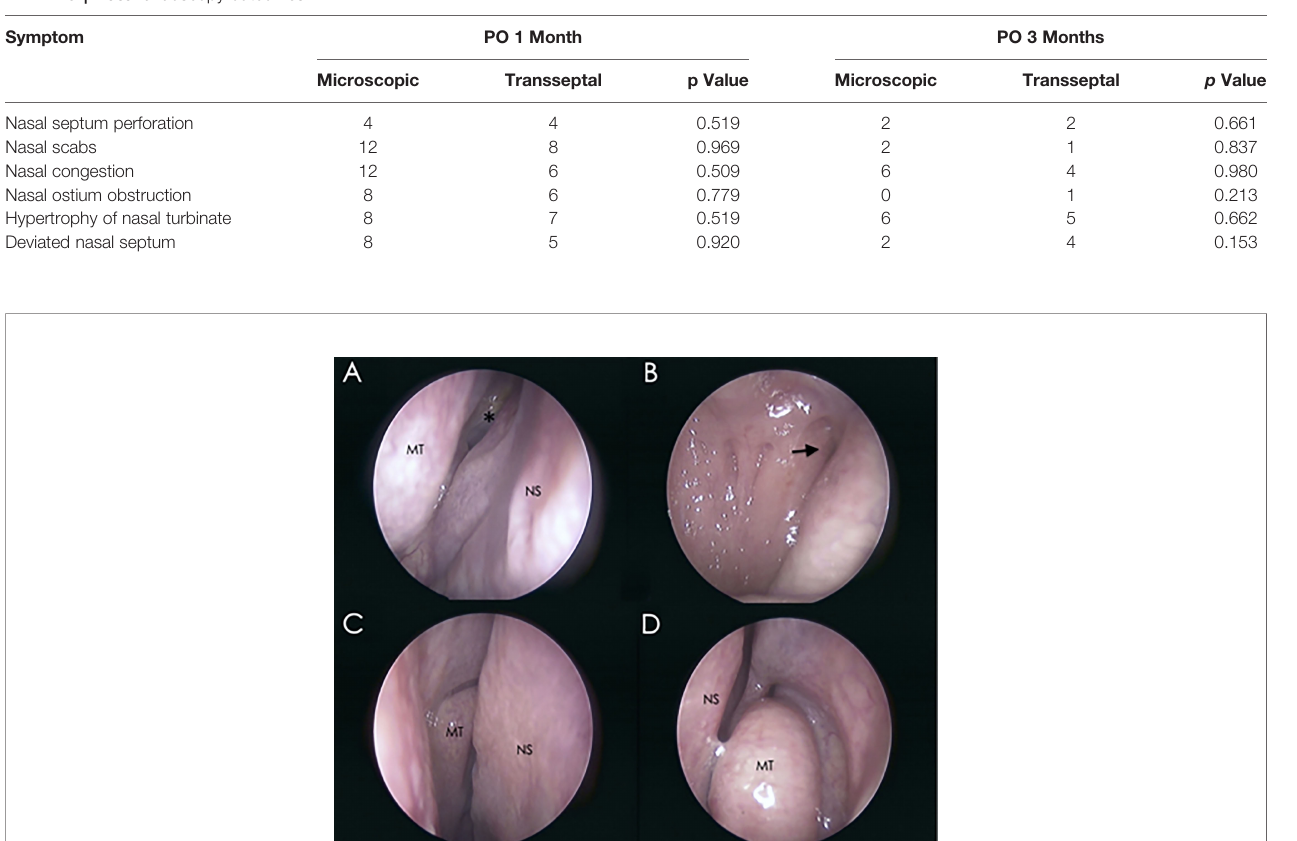
FIGURE 3 | Representative nasal endoscopic images of outpatients at 1-month follow-up after the operation. Images show the integrity of the nasal structure. (A) Endoscopic view of the sphenoid ostium from the right nostril. (B) View of the nasopharynx. (C) Endoscopic view from the right nostril. (D) Endoscopic view from the left nostril. Asterisk, sphenoid ostium; arrow, pharyngeal recess; MT, middle turbinate; NS, nasal septum.